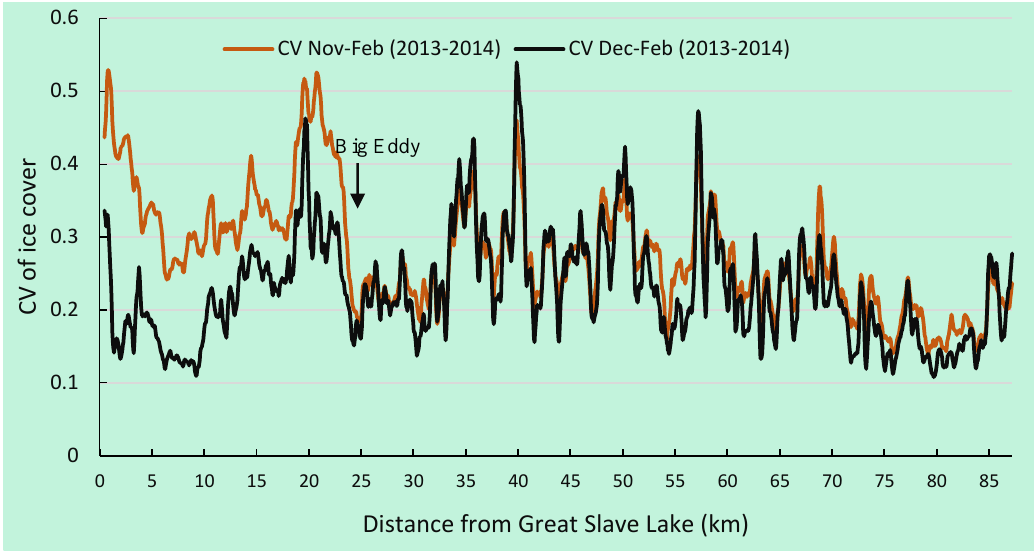
Figure 8. Profiles of backscatter-based coefficient of variation showing an intra-annual variation of ice covers along the Slave River Delta channel during the 2013–2014